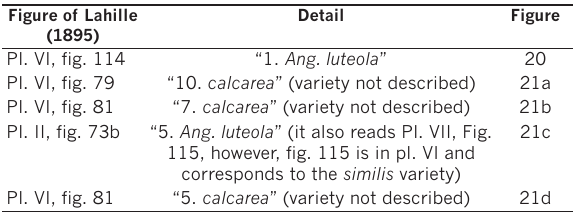
Table 7. Voluta angulata luteola , specimens figured by Lahille (1895) with the detail of the inscriptions on their shells and fig - ures